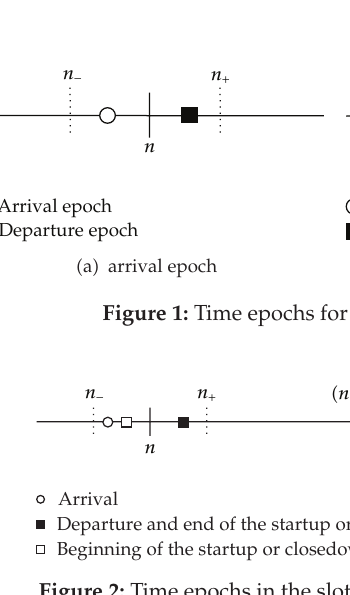
Figure 2: Time epochs in the slots n and n (cid:9) 1 under the